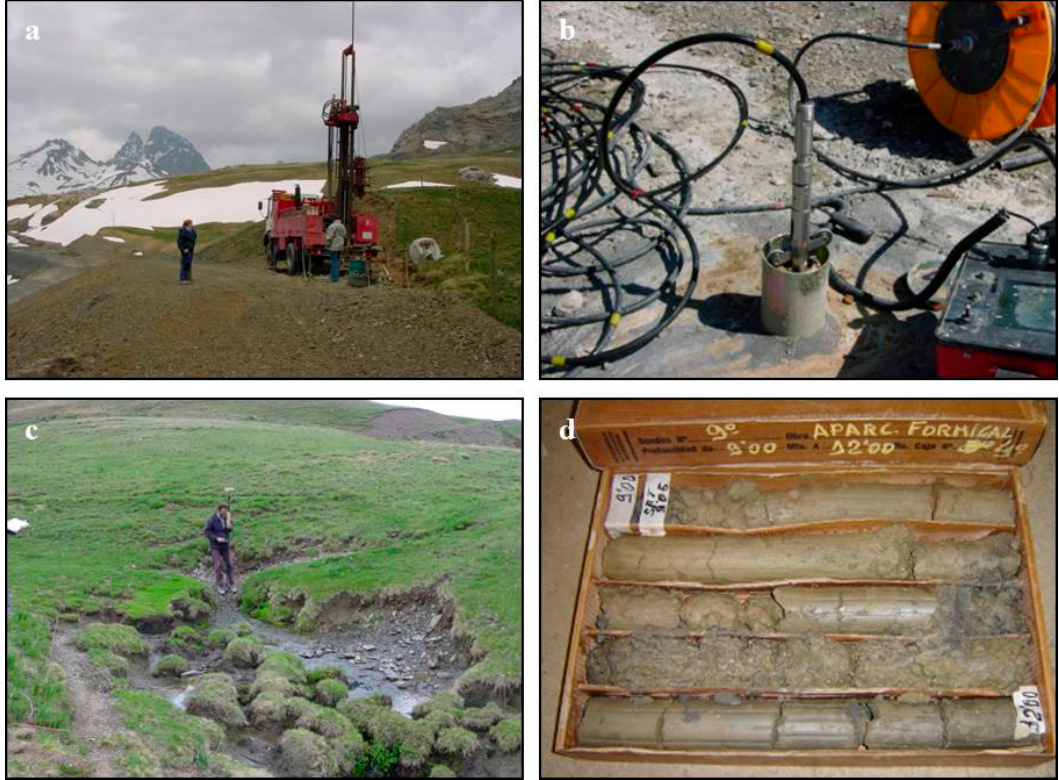
Figure 4. New geotechnical investigation works: ( a ) Borehole performance; ( b ) Inclinometer installation; ( c ) Inventory of water points; ( d ) Example of the Quaternary material obtained in the